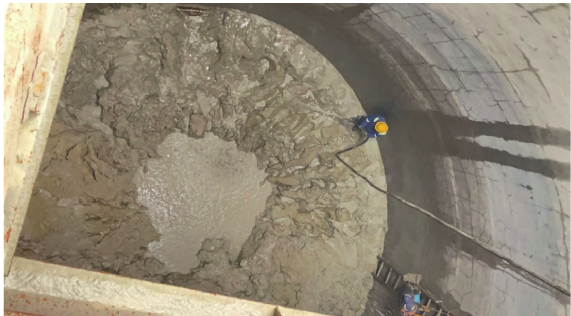
Figure 11: Deposition and consolidation of tailings.